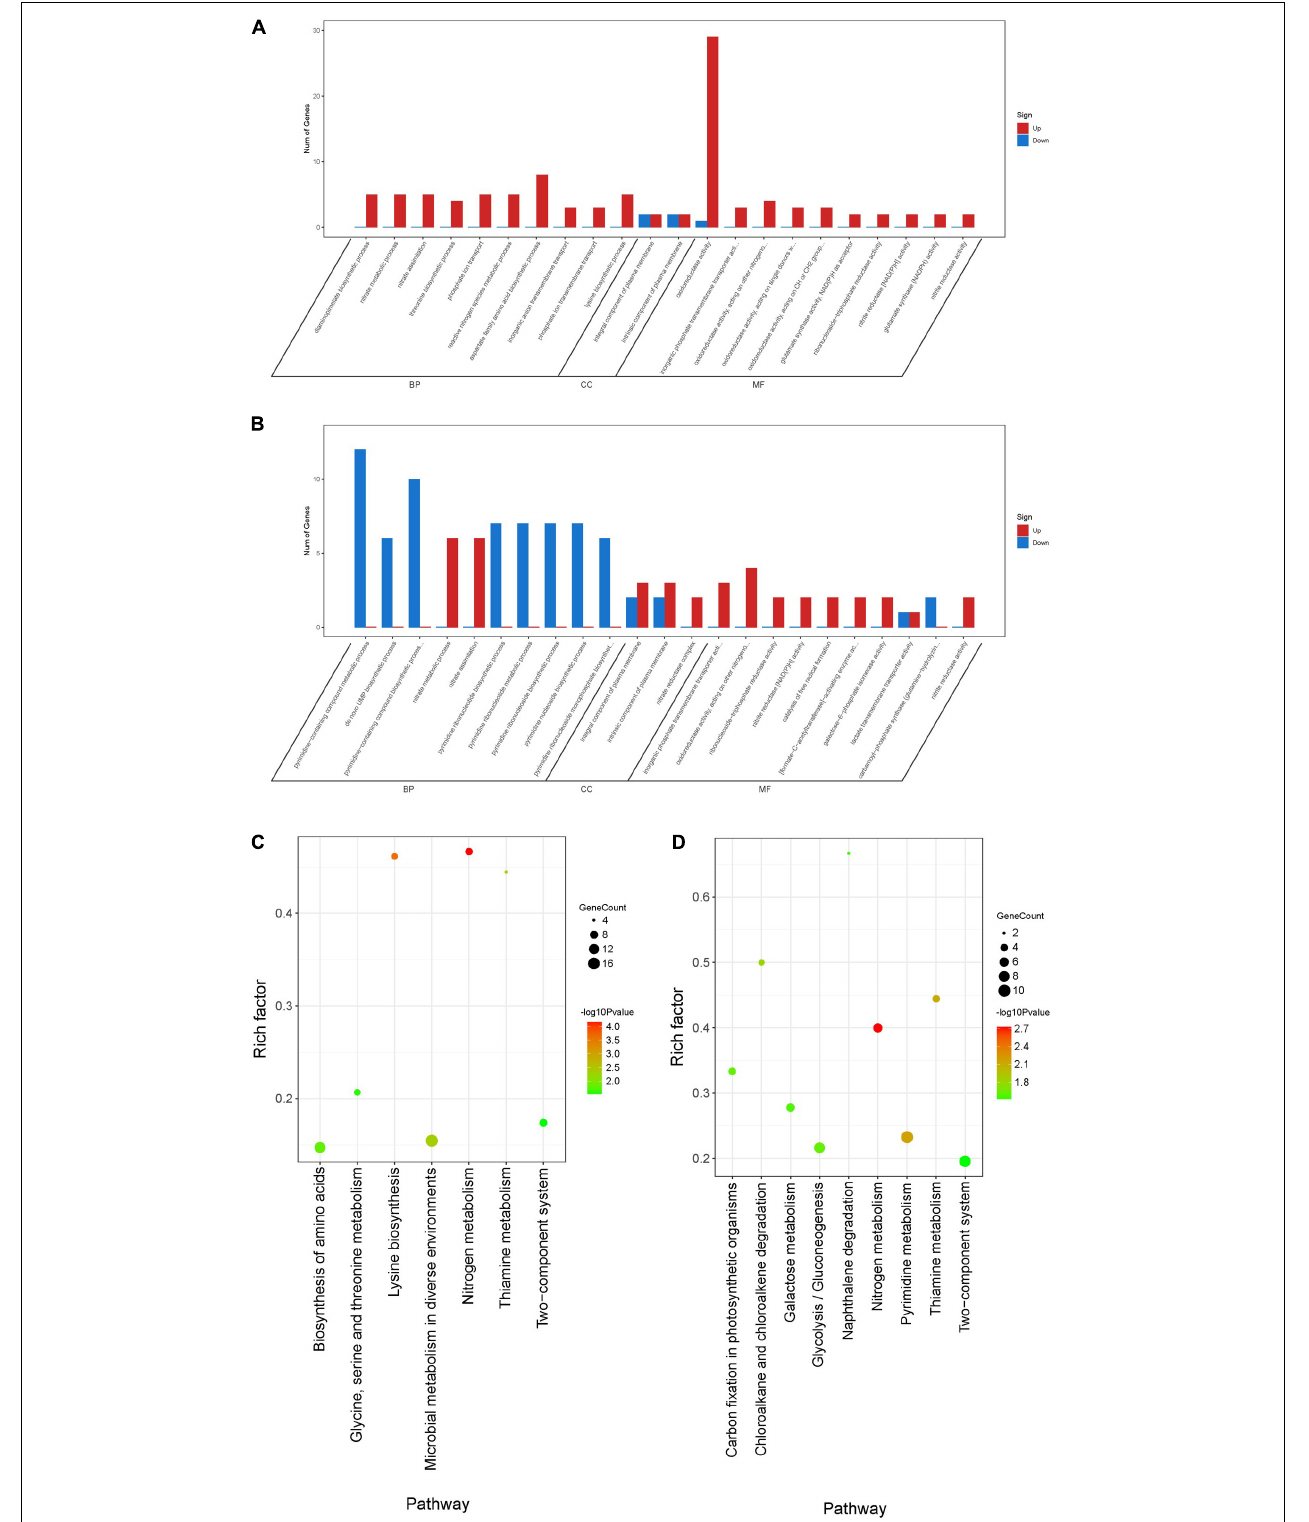
FIGURE 9 | Differentially expressed genes annotated in GO terms and KEGG pathway. (A,B) Genes annotated in three main categories: biological process, cellular component, and molecular function after treatment with compounds 6 (A) and 12 (B) . (C,D) The KEGG pathway enrichment results of compounds 6 (C) and 12 (D) treatment groups. BP, biological process; CC, cellular component; MF, molecular function.